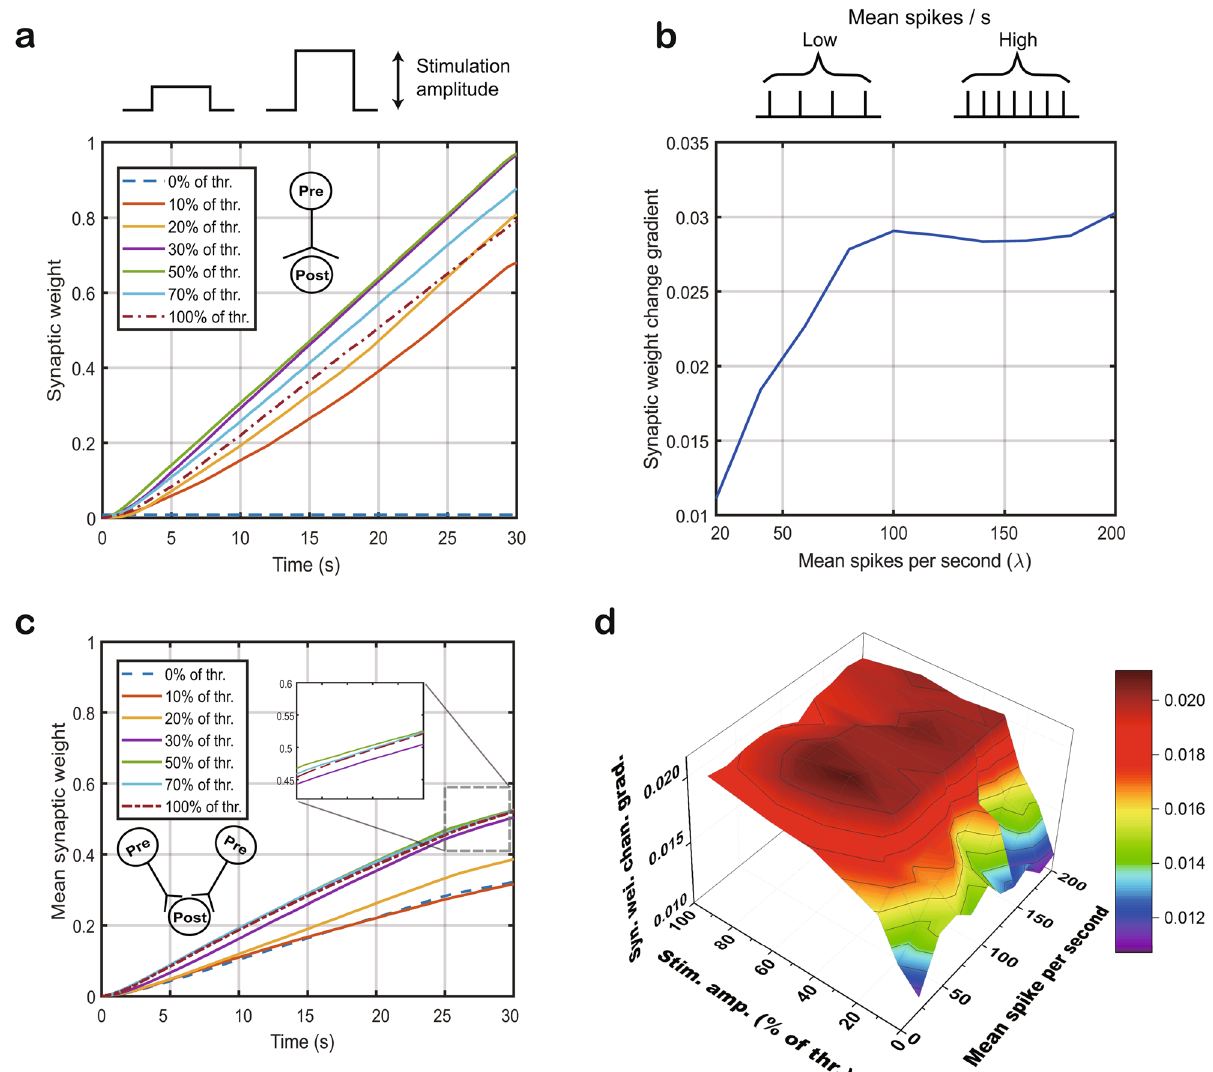
Figure 2. Synaptic weight change induced by STES and presynaptic firing. ( a ) Changes in synaptic weight in response to STES at various amplitudes from 0 to 100% of the action potential threshold amplitude. ( b ) The firing rate was controlled by mean spikes per second (i.e., λ in the Poisson process), from 10 to 200 when 30% threshold was chosen for the simulation. ( c ) Two presynaptic neurons are connected to one postsynaptic neuron to test synaptic competition effect by STES. The mean synaptic weight of two synapses increased in the simulation with presynaptic competition based on STDP. ( d ) The synaptic weight change gradient was calculated by the stimulation amplitude and the presynaptic firing rate (mean spikes per second) in the simulation with presynaptic neuron competition based on stimulation with 30% of the MT (i.e., 6–15 μA). To ensure the proper level of STES, we defined the MT at three distinct time points throughout the rehabilitation period. During the experiment, the change in the MT was less than 5 μA (Fig. S1d). We performed electromagnetic (EM) field analysis to estimate the area effectively stimu- lated by the STES. We modeled the virtual electrode and placed it in the rat phantom model, which mimics a real rat from an electrical propagation point of view (Fig. S2a-c). The electrical field (E-field) vector result in Fig. S2b shows that the multipolar stimulation with the vertical electrode formation resulted in a vertical current in cortex layer 5. Potential changes of approximately 100 and 30 mV were observed at 50 and 100 μm away from the STES location, respectively, in the simulation (Fig. S2d). This result suggests that the STES affects an area less than 100 μm from the stimulation site, which may minimize the stimulation of nontargeted brain areas. Reversible ischemia (occlusion-reperfusion) was induced to make the transient middle cerebral artery occlu- sion (mCAO) model because middle cerebral artery failure is the most common type of ischemic stroke 28 . Then, we used four groups of trained rats with implanted electrodes: sham non-STES (STES(-)), sham STES( +), mCAO STES(-), and mCAO STES( +). To examine the details during the rehabilitation process, we performed certain analyses using a particular rehabilitation timeline (Fig. 3b). During the rehabilitation process following mCAO, behavioral and physiological analyses were simultaneously started at post-mCAO days 3 ~ 4. Rehabilitation with